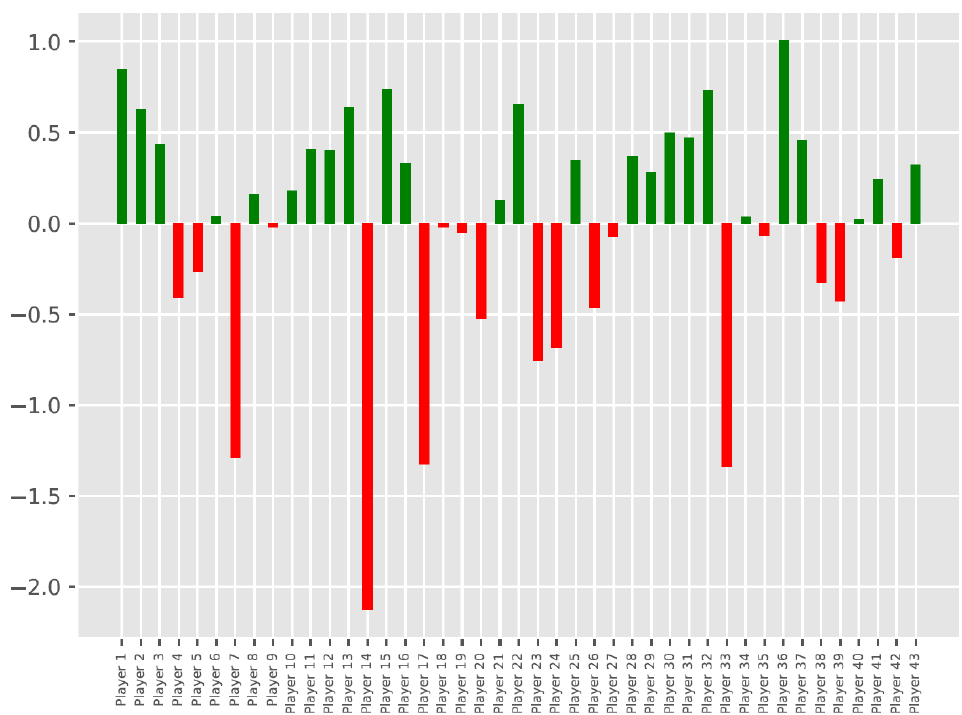
Figure 2. Visualization of the comparative analysis of CHI.b obtained among players in the team with CHI.a color-coded according to the RAG rating. Zero represents the team mean in terms of hop performance. Bars above the zero line represent athletes better than mean, while bars below zero indicate worse-than-mean athletes.